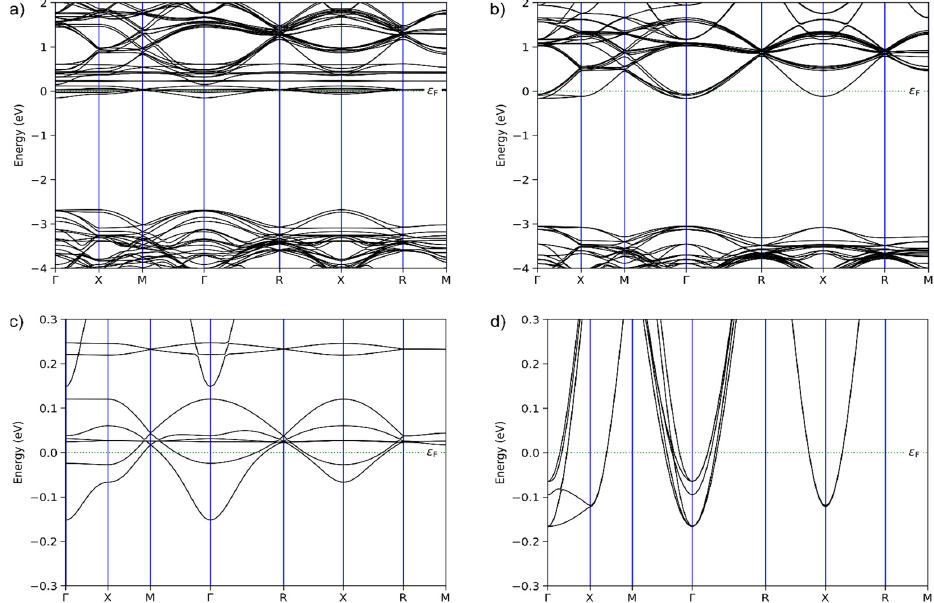
Figure 5. Band structures of ( a ) SCNPTO and ( b ) SLTO and enlarged band structures around the Fermi level of ( c ) SCNPTO and ( d ) SLTO.